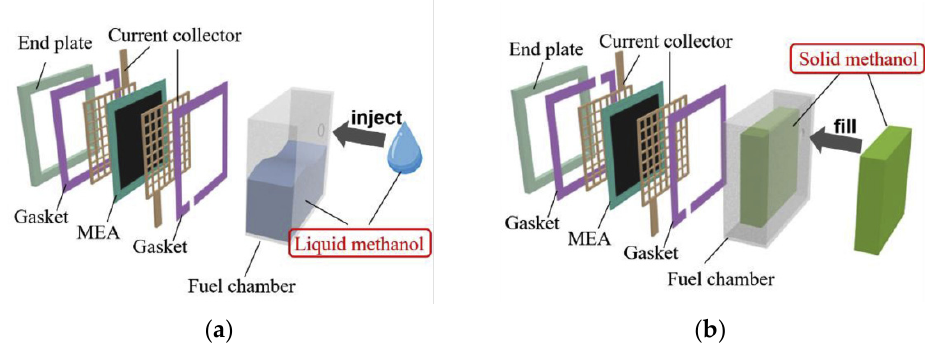
Figure 11. Schematic diagram of passive DMFCs: ( a ) conventional liquid-fed device; ( b ) new solid- state device. Reproduced from [125] with permission from Elsevier 2020.